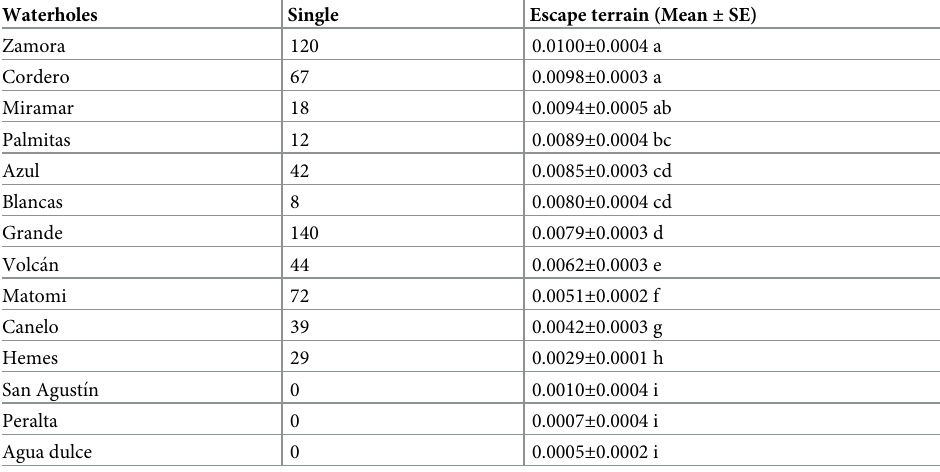
Table 4. Escape terrain values (mean ± SE; P < 0.05) at waterholes in Sierra Santa Isabel, Baja California, Mexico. Means with different letters are statistically different based on Fisher’s LSD multiple comparison test.